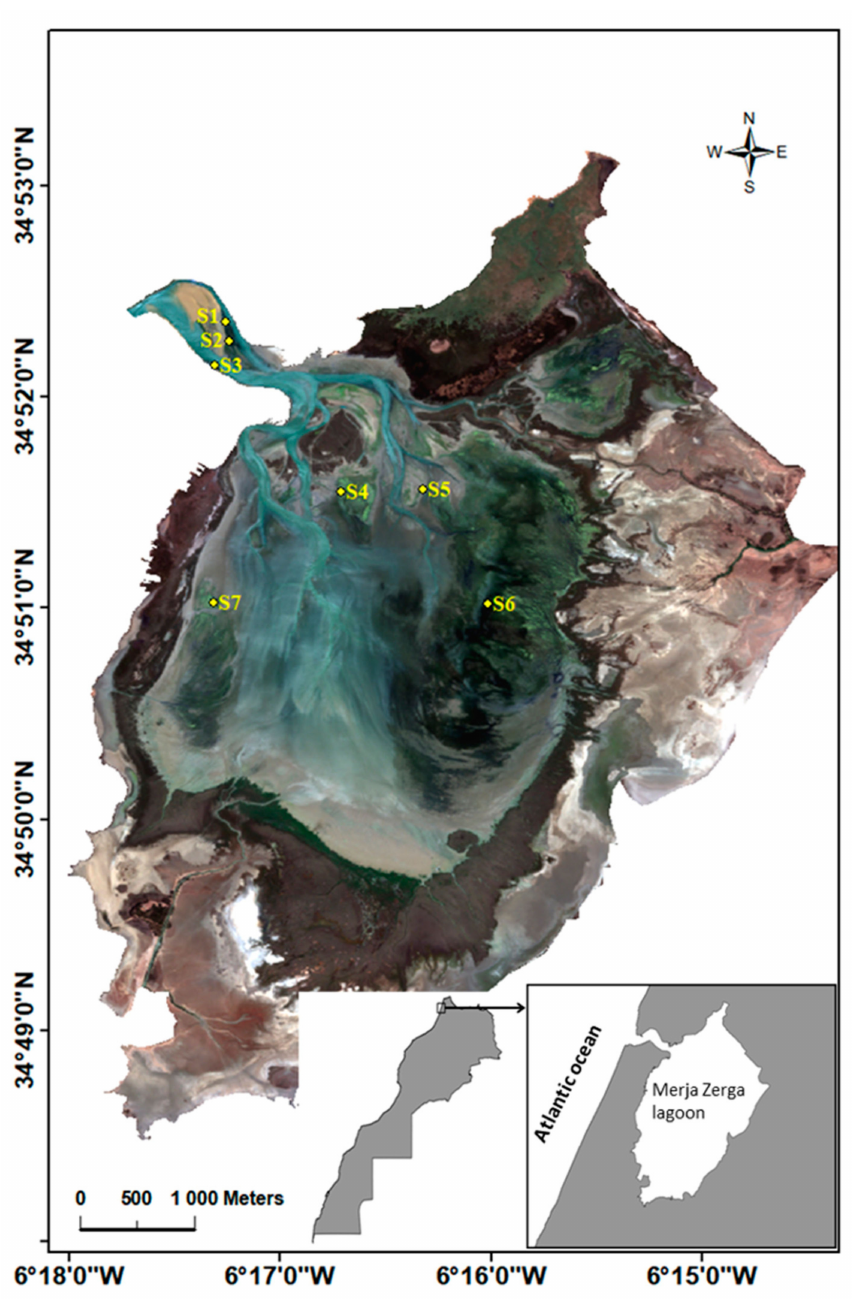
Figure 1. Z. noltei sampling stations in the Merja Zerga lagoon: S1, S2, S3, S4, S5, S6, S7 (source: Image SPOT